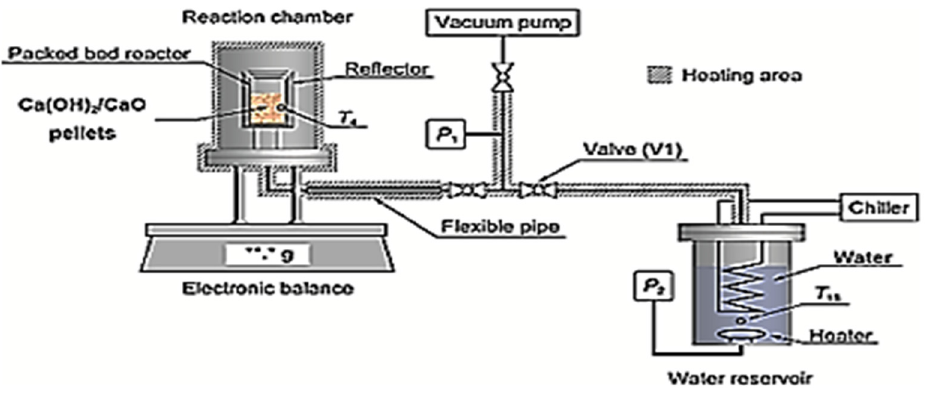
Figure 11. Schematic diagram of the experimental setup in Funayama et al. [128].